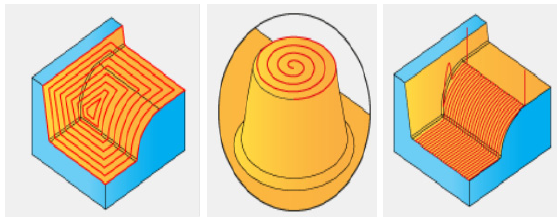
Figure 5. Finishing strategies: Constant step over (left), Spiral (middle), and Linear (right) [12]